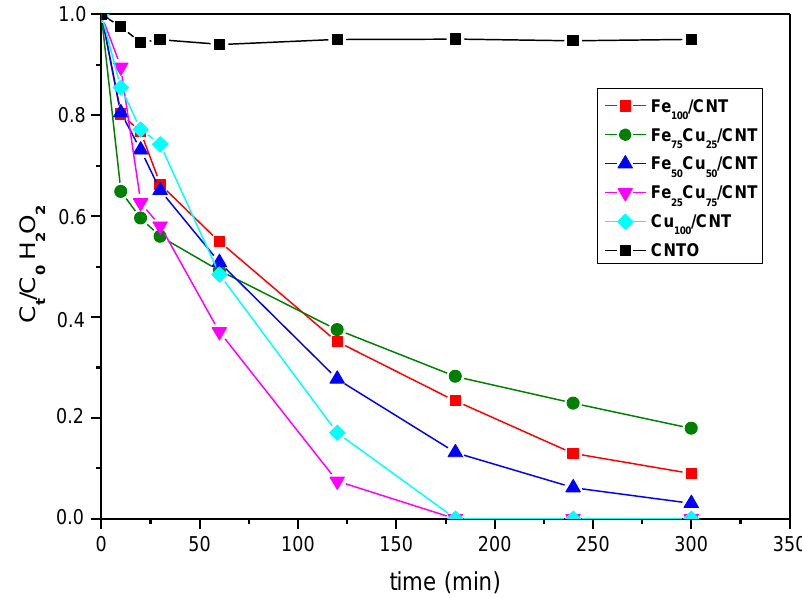
Figure 4. Decomposition kinetics of H 2 O 2 (C 0 = 13.8 × 10 −3 mol/L) in absence of paracetamol at 25 °C on CNTO and Fe 100−x Cu x /CNT samples.